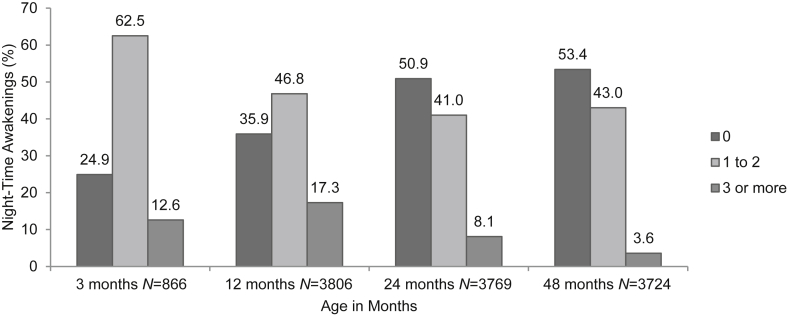
Awakenings (shown as %) at four time points in childhood.